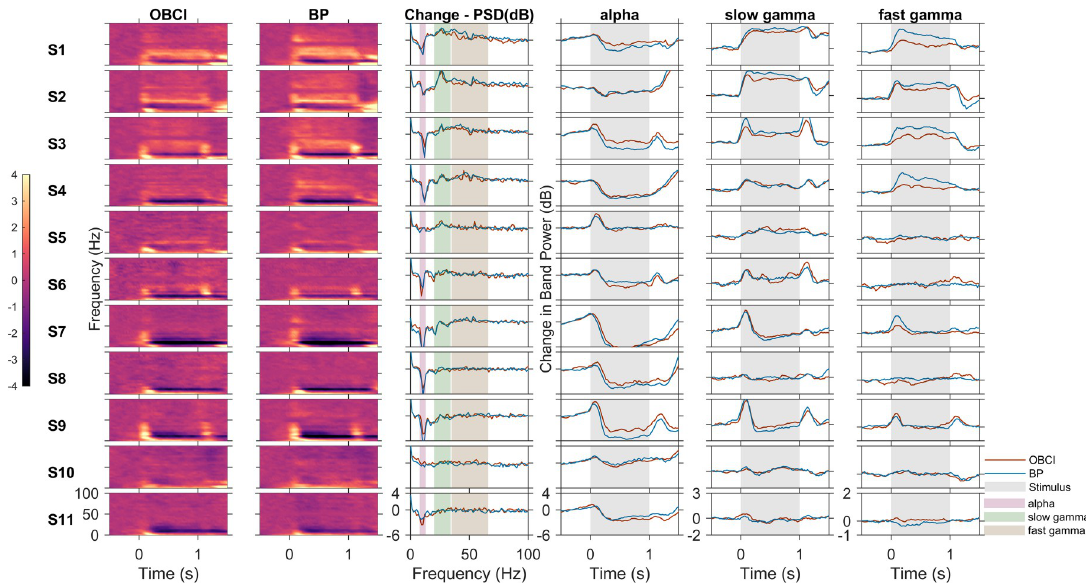
Fig 3. Comparison of OpenBCI and BrainProduct recordings for all subjects. Baseline subtracted time frequency spectrograms for OpenBCI ( first column and red trace in other columns) and Brain Products ( second column and blue trace in other columns), change in PSD (dB) from baseline in stimulus period vs frequency ( third column ), change in power (dB) with time for alpha ( fourth column ),slow gamma ( fifth column ) and fast gamma ( sixth column ) bands. Vertical bands in the last three columns indicate stimulus duration ( grey ). Each row represents one subject. The subjects are numbered in decreasing order of total gamma